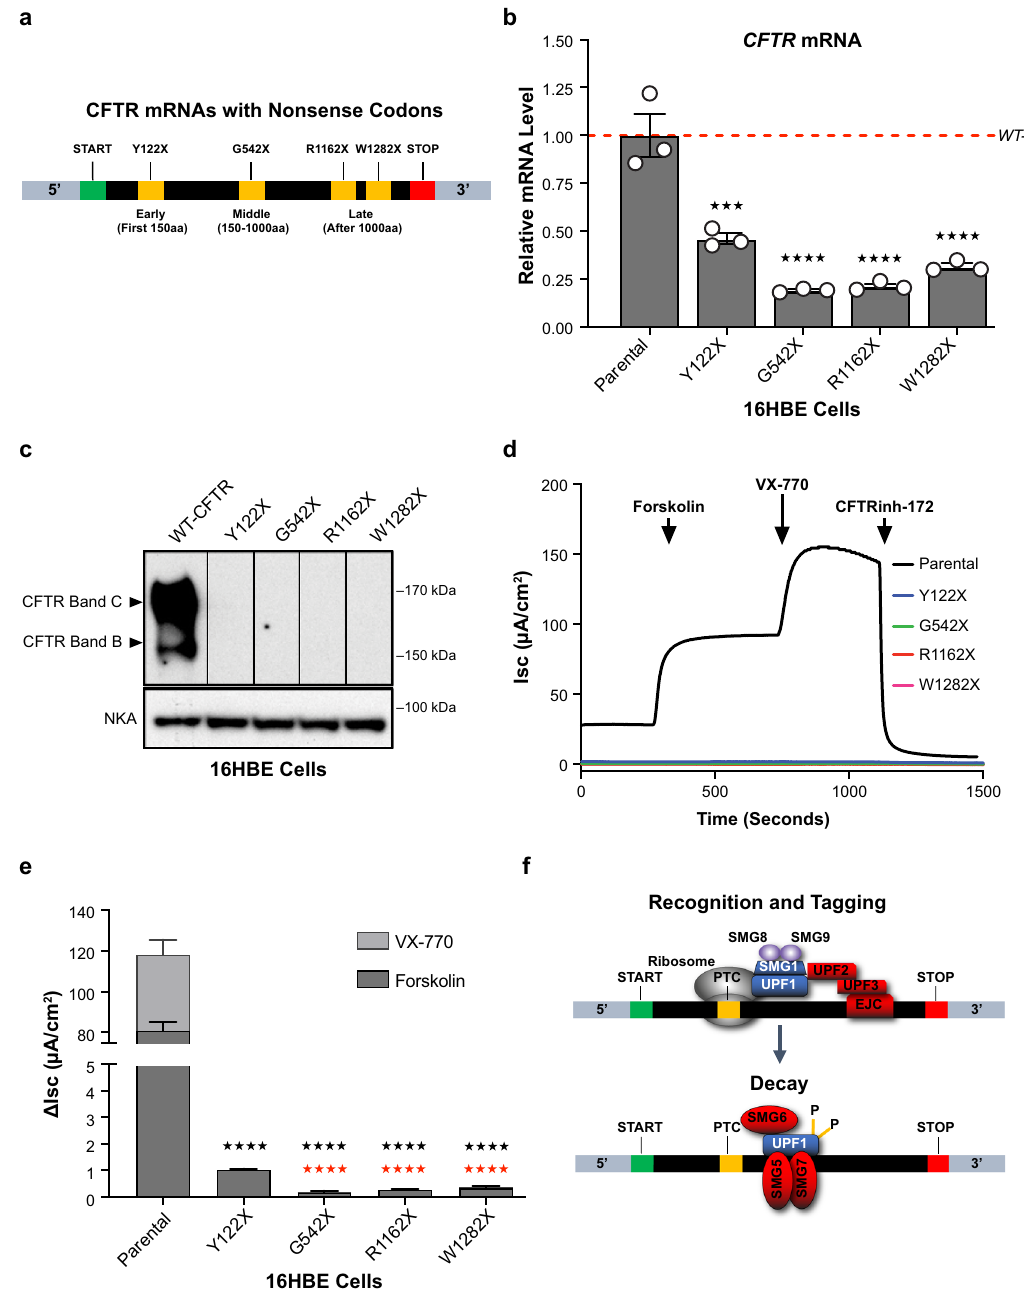
Fig. 1 Characterization of the CFF-16HBEge in vitro model system. CFF-16HBEge cells with CFTR Y122X, G542X, R1162X, and W1282X nonsense mutations have signi fi cantly reduced CFTR expression and function when compared to parental cells. a A schematic displaying CFTR nonsense mutations which were evaluated in this study. b RT-qPCR analysis of CFTR mRNAs in parental and CFF-16HBEge cells with Y122X, G542X, R1162X, or W1282X CFTR nonsense mutations. CFTR mRNA levels were normalized to total RNA levels ( n = 3 for each group). The wild-type (WT) CFTR mRNA level in parental cells was set to 1 and is indicated by the dotted red line. c Representative western blot image of CFTR protein expression in parental and CFF-16HBEge cells. Na + /K + -ATPase (NKA) protein was used as a loading control ( n = 3 for each group). d Representative short circuit current (Isc) traces of parental and CFF- 16HBEge cells obtained using the Ussing Chamber assay. 7 µ M benzamil was added to establish baseline current followed by the sequential addition of 20 µ M forskolin, 1 µ M VX-770, and 20 µ M CFTR inhibitor-172 (CFTRinh-172) at times indicated by arrows. e Δ Isc of CFTR-attributed current in parental and CFF-16HBEge cells ( n = 4 for parental, n = 5 for CFF-16HBEge-Y122X, n = 3 for CFF-16HBEge-G542X, n = 4 for CFF-16HBEge-R1162X, and n = 5 for CFF-16HBEge-W1282X cells). f A schematic displaying the recognition, tagging, and decay steps of the NMD pathway. Core NMD factors are indicated by the color blue, SMG1-cofactors SMG8 and SMG9 are indicated by the color purple, and branch-speci fi c NMD components are colored red. Data are presented as mean ± SEM from biologically independent samples. Statistical signi fi cance was analyzed by one-way ANOVA followed by Dunnett ’ s multiple-comparison test (*** p < 0.001, **** p < 0.0001). Black stars indicate statistical comparisons made between parental cells and CFF-16HBEge cells. Red stars indicate statistical comparisons made between CFF-16HBEge-Y122X and CFF-16HBEge-G542X, -R1162X, and -W1282X cells. See Source Data fi le for the exact p -values. Source data are provided as a Source Data fi